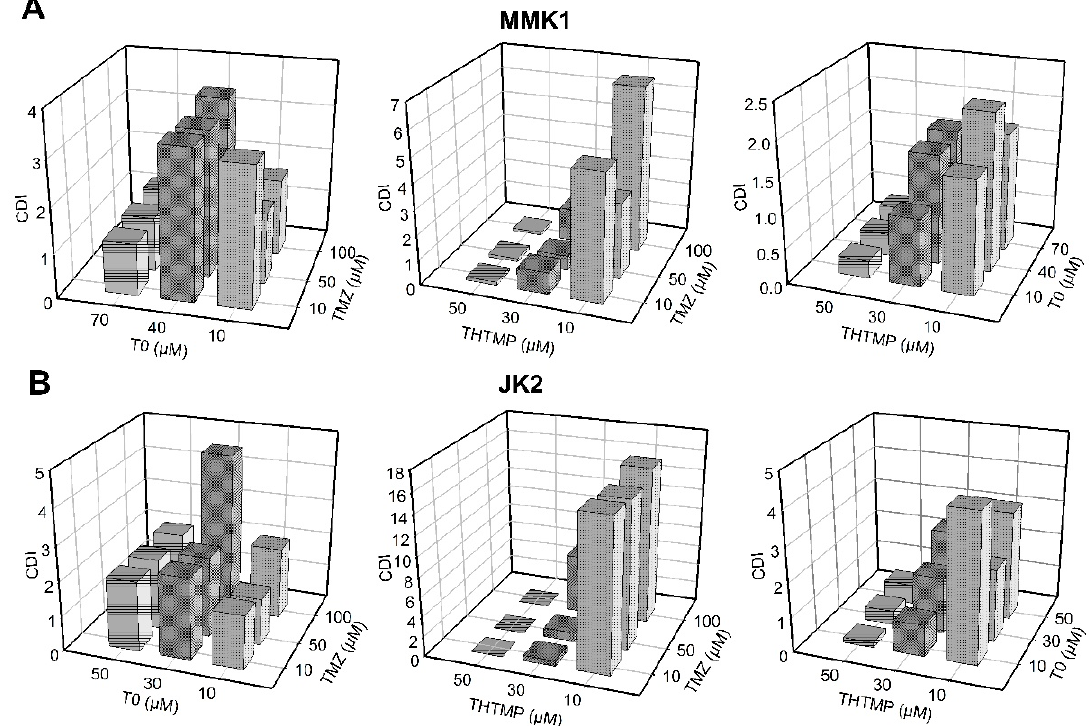
Figure 2. The coefficient of drug interaction (CDI) values for combinatorial drugs (T0 + TMZ), (THTMP + TMZ) and (THTMP + T0) of ( A ) MMK1 and ( B ) JK2 cells.